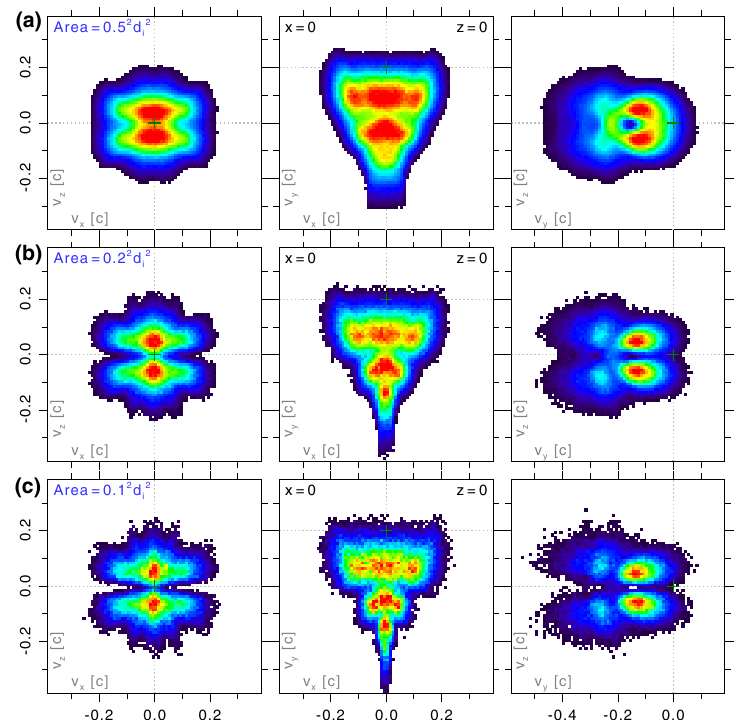
Figure 4. Comparison of different analysis area sizes. Panel row (a) is averaged similar to Zenitani and Nagai (2016), (b) reflects the quality presented in this work, and (c) features an even smaller analysis area size; see Sect.